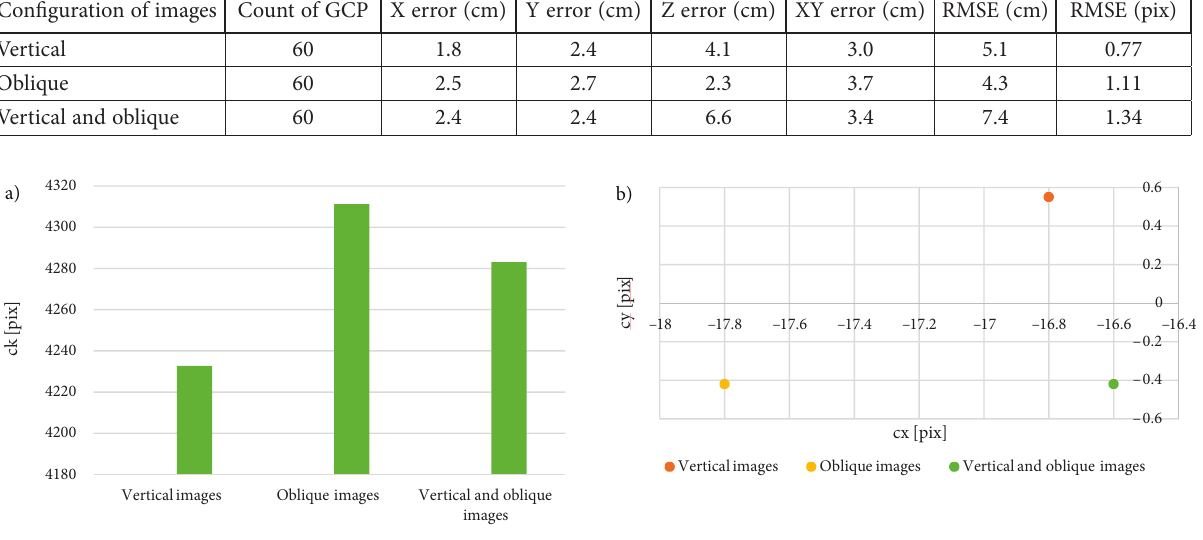
Figure 7. Comparison of the obtained parameters of the camera’s internal orientation for the three analyzed variants: a – distribution of changes in the camera constant; b – distribution of changes in the coordinates of the principal